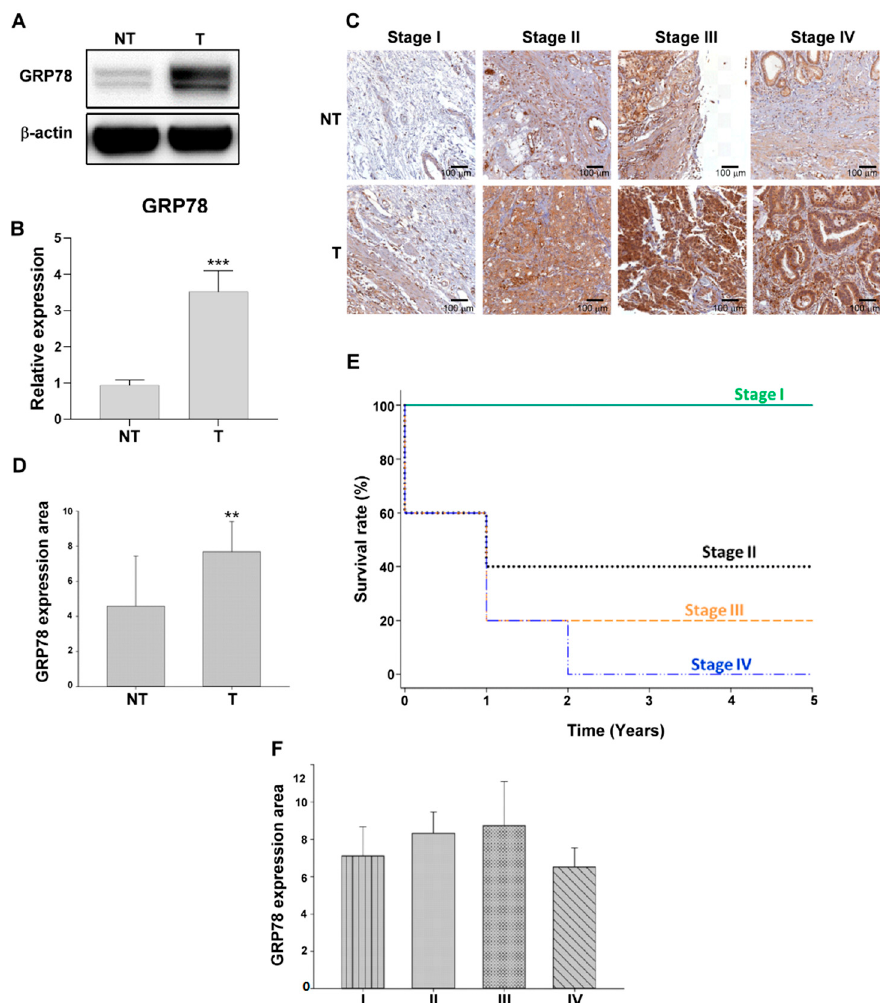
Figure 1. Glucose-regulated protein 78 (GRP78) was overexpressed in patients with gastric cancer. ( A ) Expression of GRP78 in tumor and normal tissues in patients with stage I cancer. ( B ) Quantification of GRP78 expression in the tissue samples of patients with gastric cancer. ( C ) GRP78 expression was analyzed by performing immunohistochemistry (IHC) analysis in tumor and normal tissue samples of patients with stage I to stage IV cancer. ( D ) Quantification of GRP78 expression in the tumor tissue samples of patients with stage I gastric cancer compared with their corresponding normal tissues through IHC staining. ( E ) Kaplan–Meier curves for overall survival rates associated with GRP78 expression in gastric cancer. ( F ) Quantification of GRP78 expression analyzed through IHC staining in the tumor tissues of patients with stage I to stage IV cancer. Data are expressed as the mean ± standard error of mean; n ≥ 3 independent experiments, two-tailed Student’s t test: ** p < 0.01, *** p < 0.005